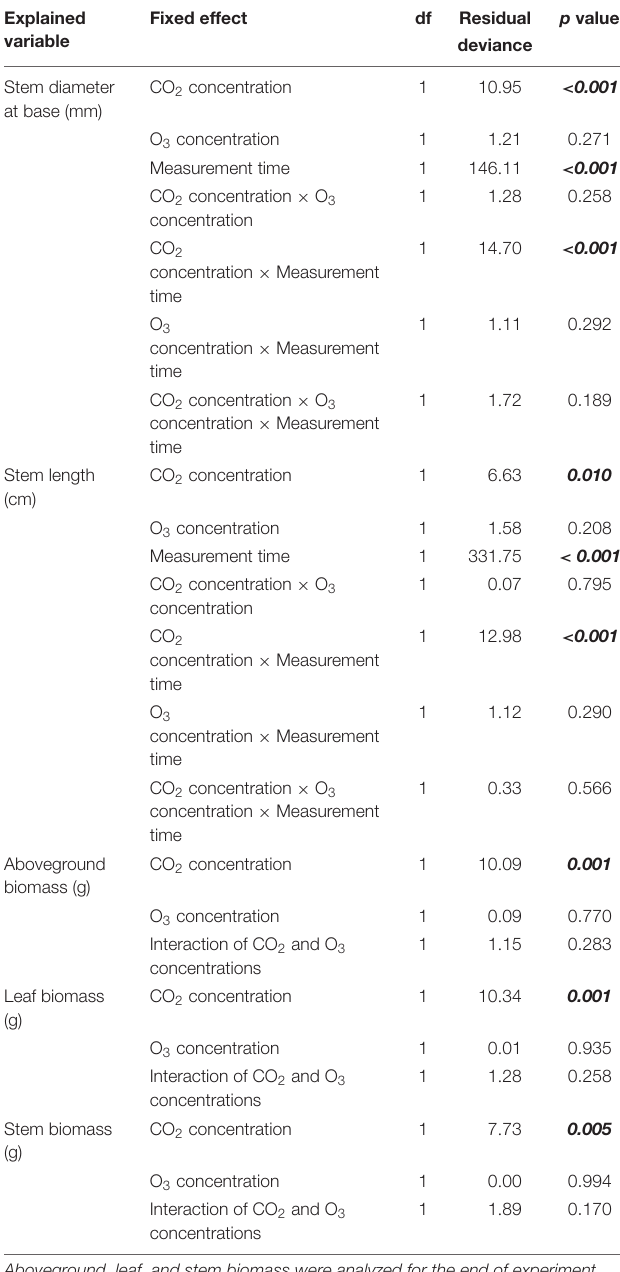
TABLE 2 | Results of the analysis of deviance (type II test) for stem size and aboveground, leaf, and stem biomass at the start and end of the experiment. Explained